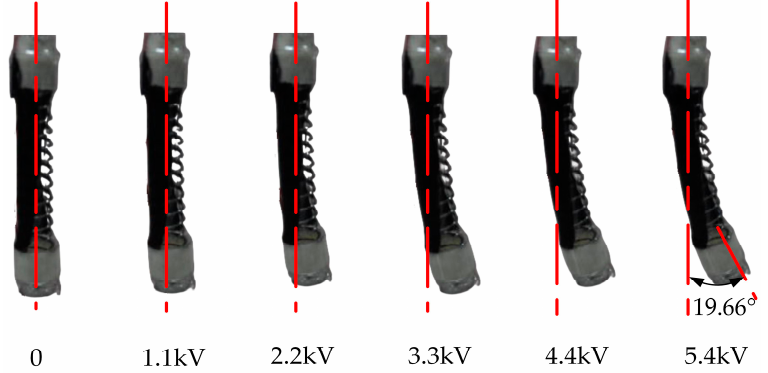
Figure 13. The deformations with the voltage from 0 to 5.4 kV (from left to right).